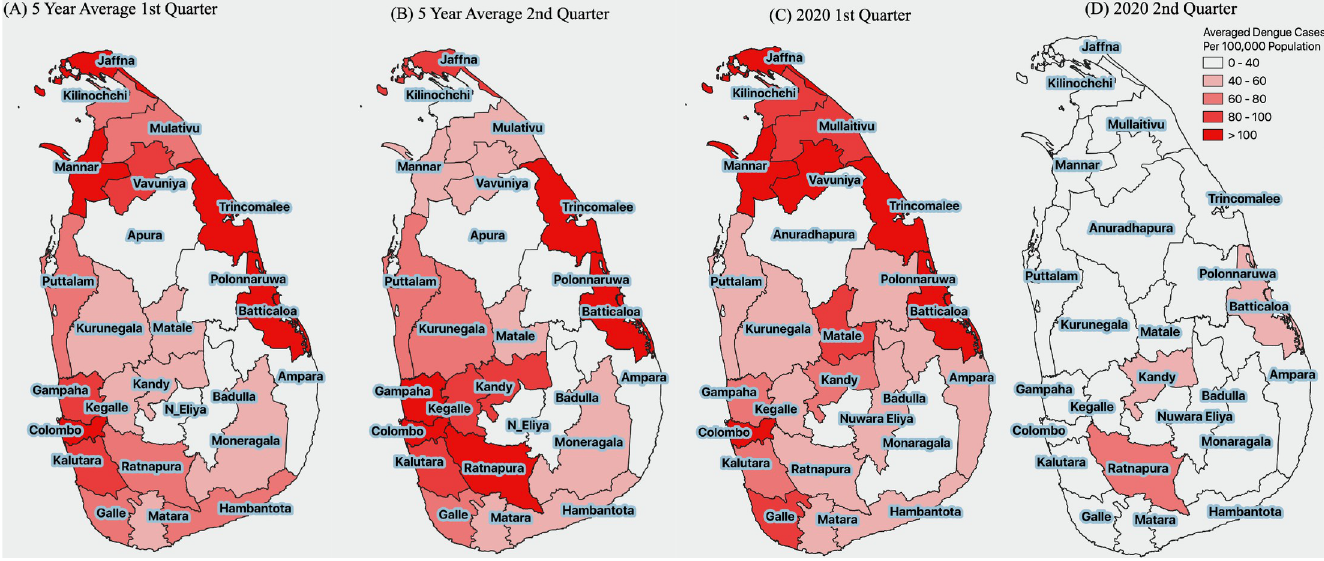
Fig 1. Distribution of dengue cases per 100,000 population during first and second quarters within administrative districts in Sri Lanka. (A) Averaged dengue cases from 2015 during 1 st quarter. (B) Five-year average during and 2 nd quarter. (C) Observed cases during first quarter 2020. (D) Observed cases during second quarter 2020 per 100,000 population in Sri Lanka. Source of the base file: https://data.humdata.org/dataset/sri-lanka-administrative-levels-0-4-boundaries.